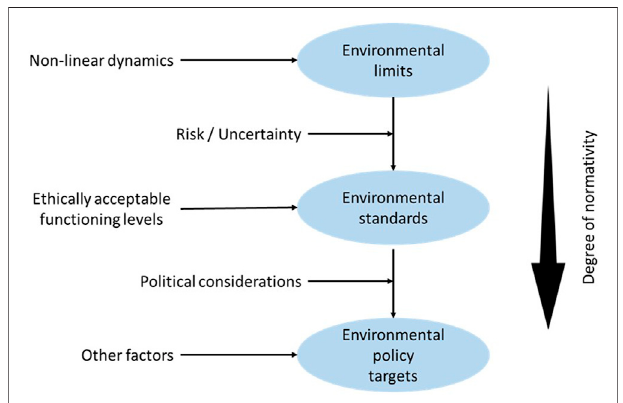
FIGURE 1 | Relationship between environmental limits, standards and policy